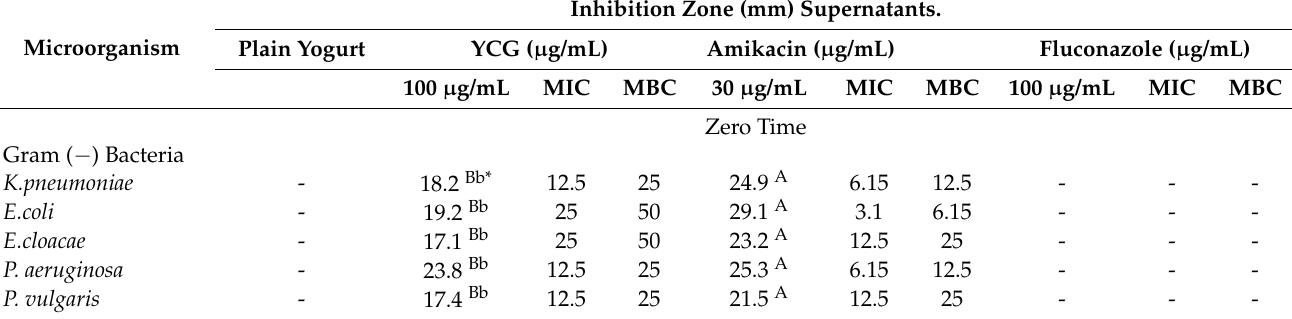
Table 1. Antimicrobial activity, Minimum inhibitory concentrations (MIC), and Minimum bacterici- dal/fungicidal concentrations (MBC/MFC) of YCG supernatant. Inhibition Zone (mm) Microorganism